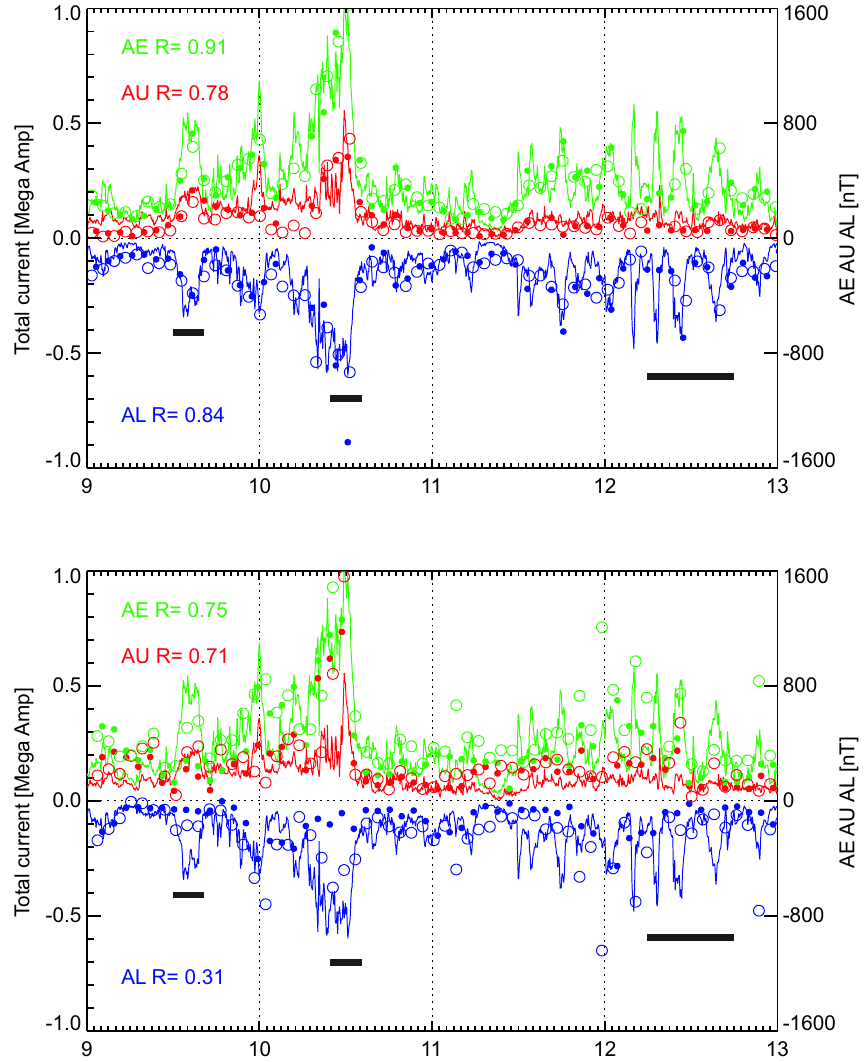
Fig. 3. The time series of ground-based auroral indices and current indices from both Ørsted and CHAMP for the time period 9–12 November 2000 are displayed. The upper panel is for the Northern Hemisphere, the lower panel for the Southern Hemisphere. In both panels, the A L index and the corresponding satellite indices for westward current are drawn in blue color; the full line is the 5-min average A L index, the filled circles are Ørsted values, and the bigger open circles are CHAMP values. The A U index and the corresponding eastward satellite current indices are plotted in the same way in red color. Finally, in the green color the A E index is plotted, together with the total absolute current indices for the two satellites. Black bars in the upper panel point out periods that are discussed specifically in the